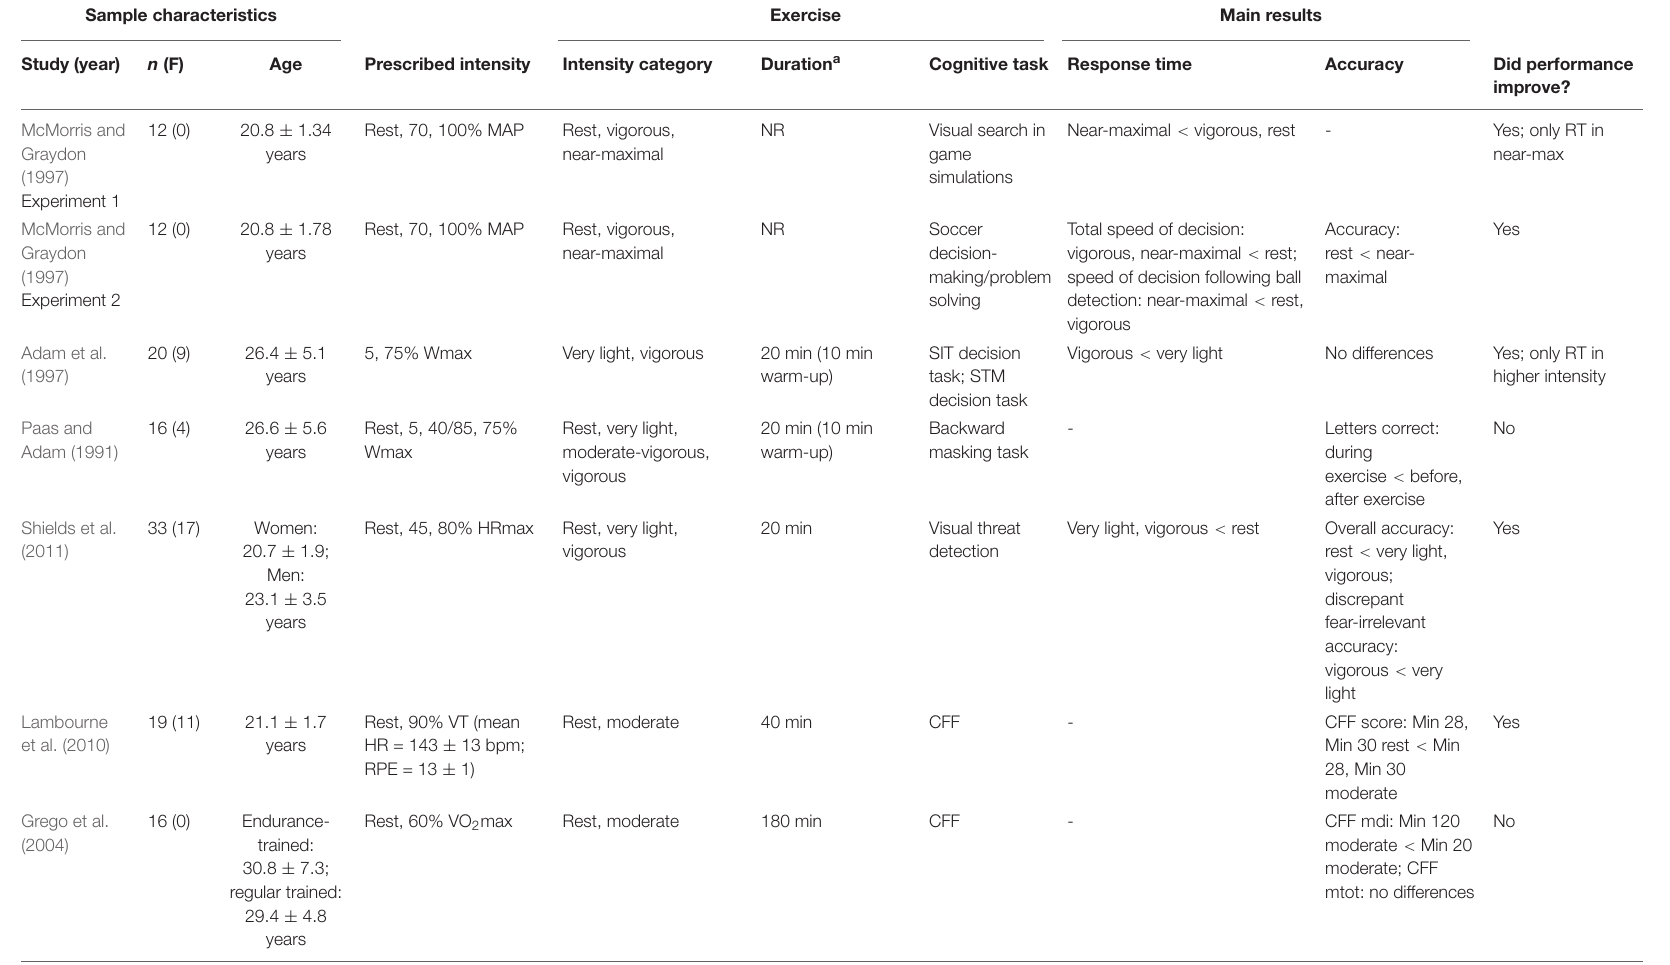
TABLE 6 | Summary of studies examining information processing during acute aerobic